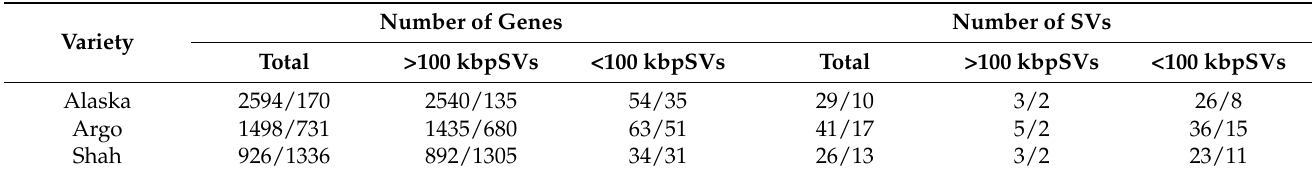
Table 5. Numbers of genes in the SVs.